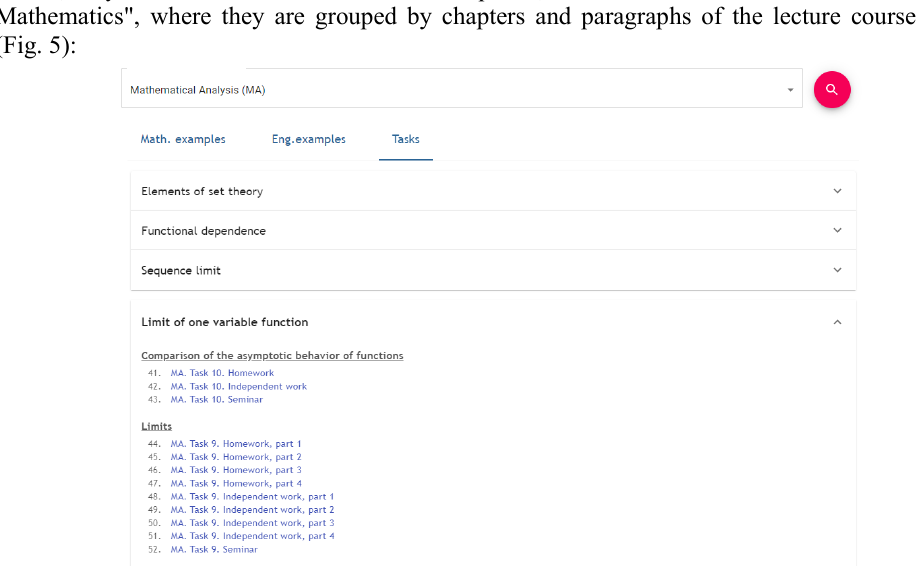
Fig. 5. Section "Visual Mathematics" in DLS